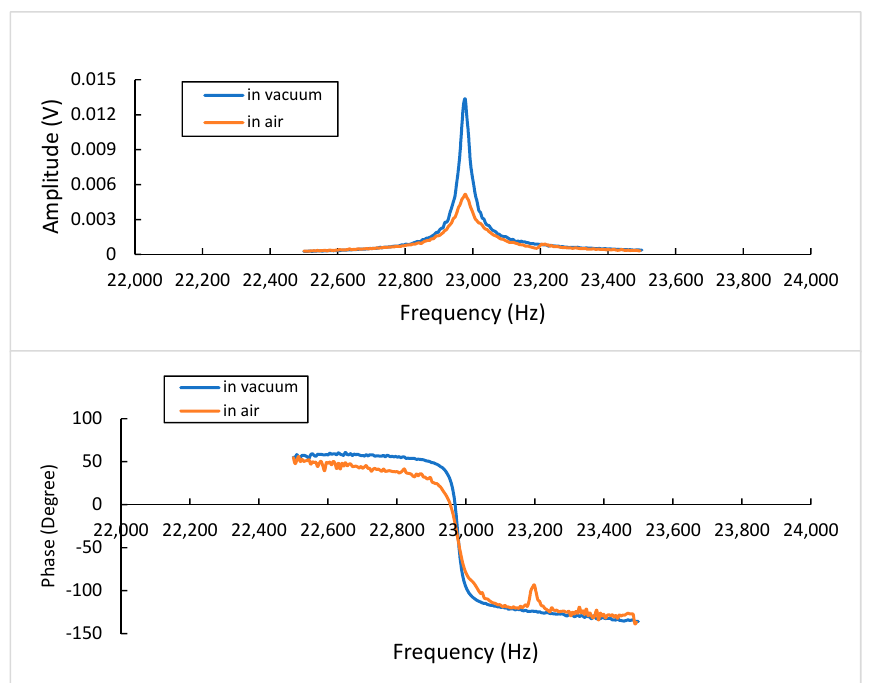
Figure 11. Frequency response of mode (0,0)-vibrometer measurement.